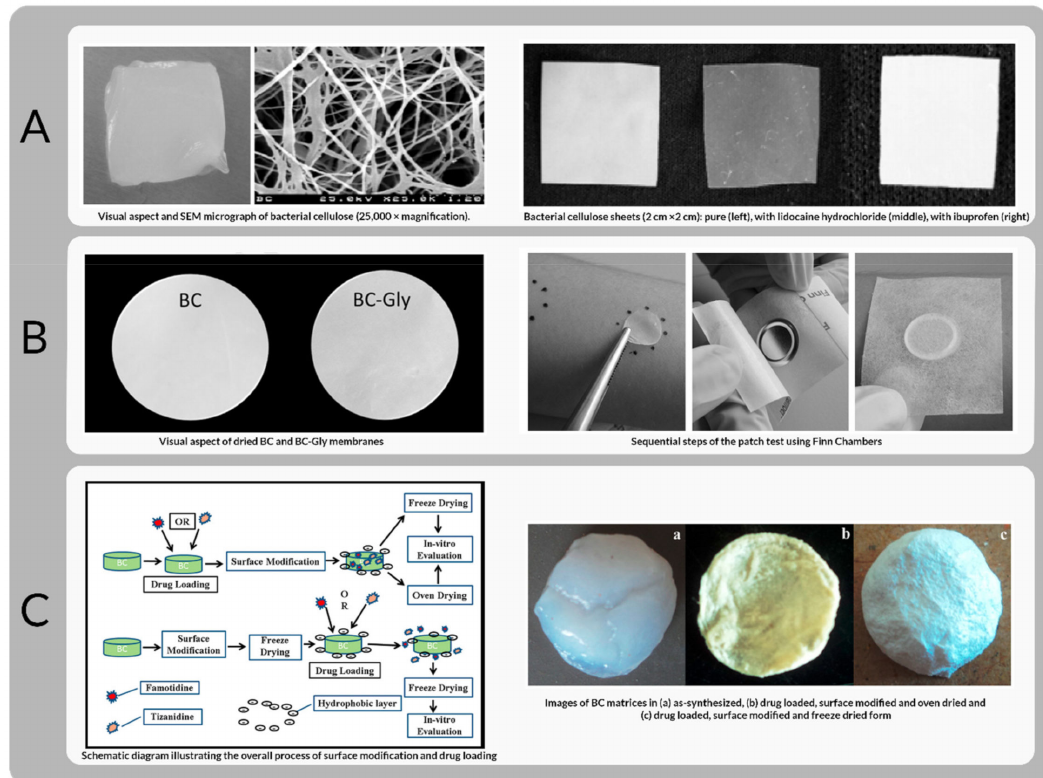
Figure 10. Images adapted from key studies using the ex-situ (ExSUP) modification method. ( A ) SEM micrograph of bacterial cellulose and BC sheets treated with lidocaine hydrochloride (middle) and ibuprofen (right); adapted with permission from [16]. ( B ) Visual aspect of dried BC and BC-Gly mem- branes and Sequential steps of the patch test using Finn Chambers; adapted with permission from [30]. ( C ) Schematic diagram illustrating the overall process of surface modification and drug loading and Images of BC matrices in ( a ) as-synthesized, ( b ) drug loaded, surface modified and oven dried and ( c ) drug loaded, surface modified and freeze-dried form; adapted with permission from